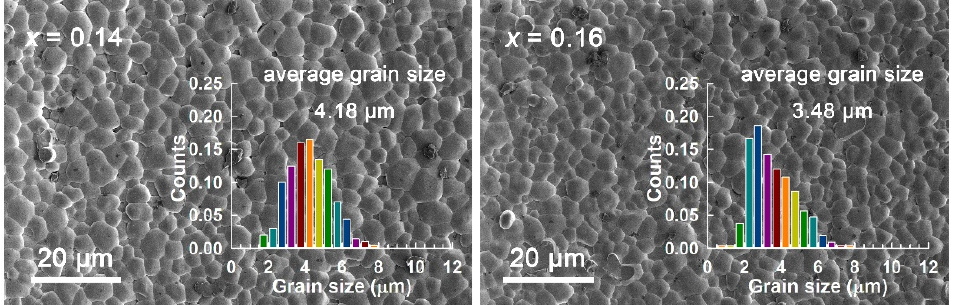
Figure 5. SEM images of BT- x CS and the corresponding grain size distributions.